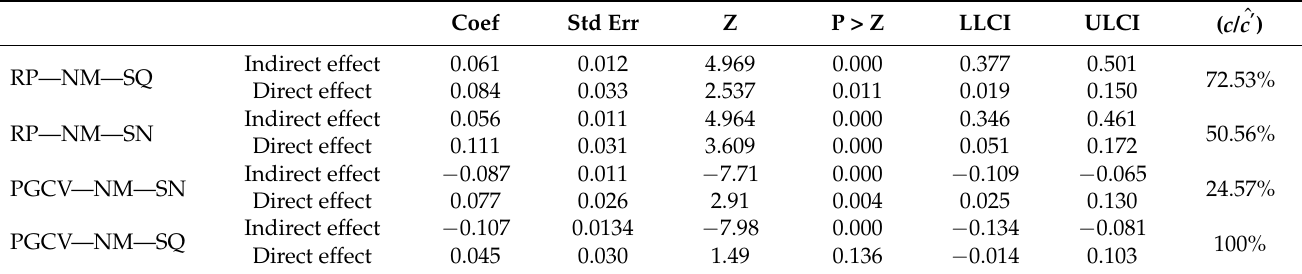
Table 3. Mediation effects of negative emotions.